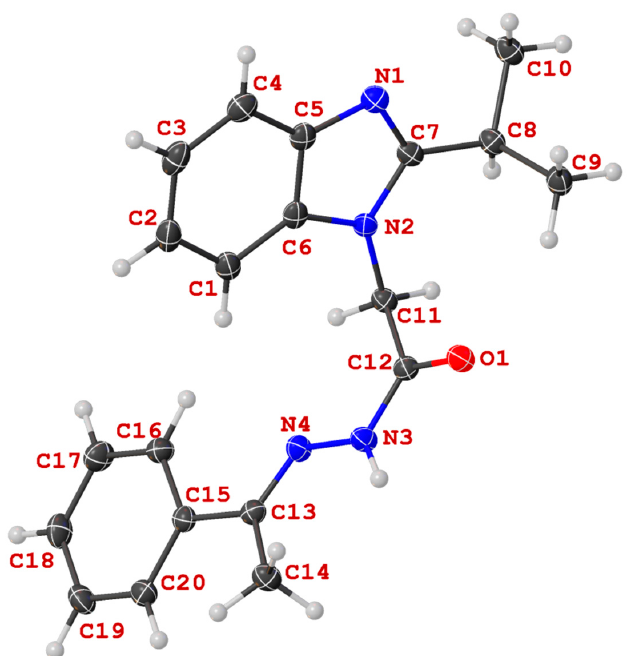
Figure 7. View of the structure of ( N '-(-1-phenylethylidene)-2-(2-(propan-2-yl)-1 H -benzimidazol-1-yl)acetohydrazide ( 14a ) in the crystal.